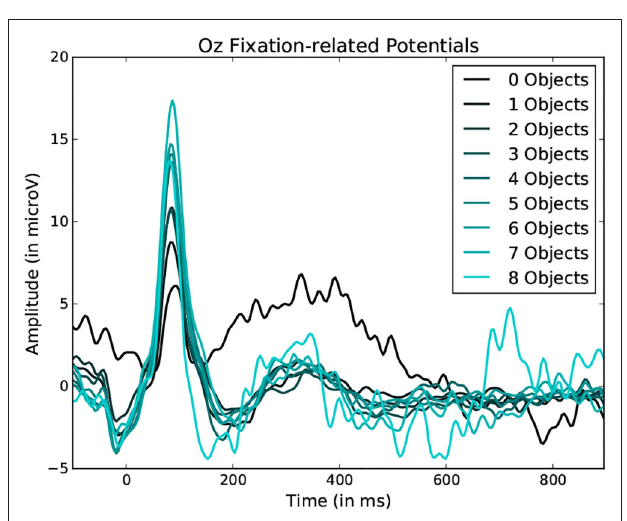
FIGURE 10 | Average Fixation related potential epoch profiles recorded on the Oz electrode. The lighter the color, the more different colors were present within the fixated region. Data from one participant was used in this